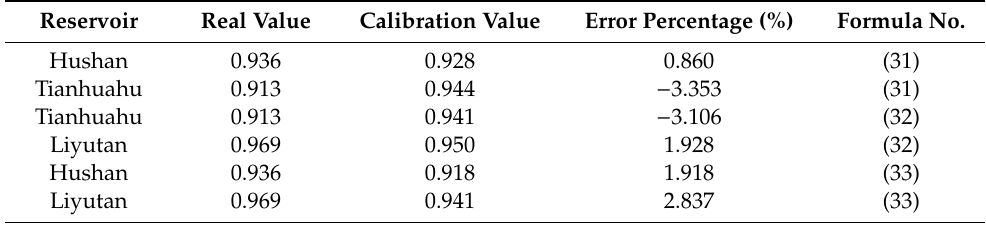
Table 12. The verification results of reasonable WSRI estimation